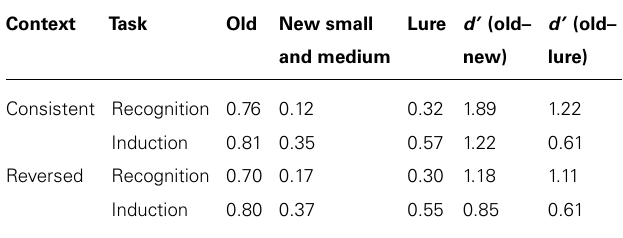
Table 1 | Proportion of “yes” responses and d’s for recognition and